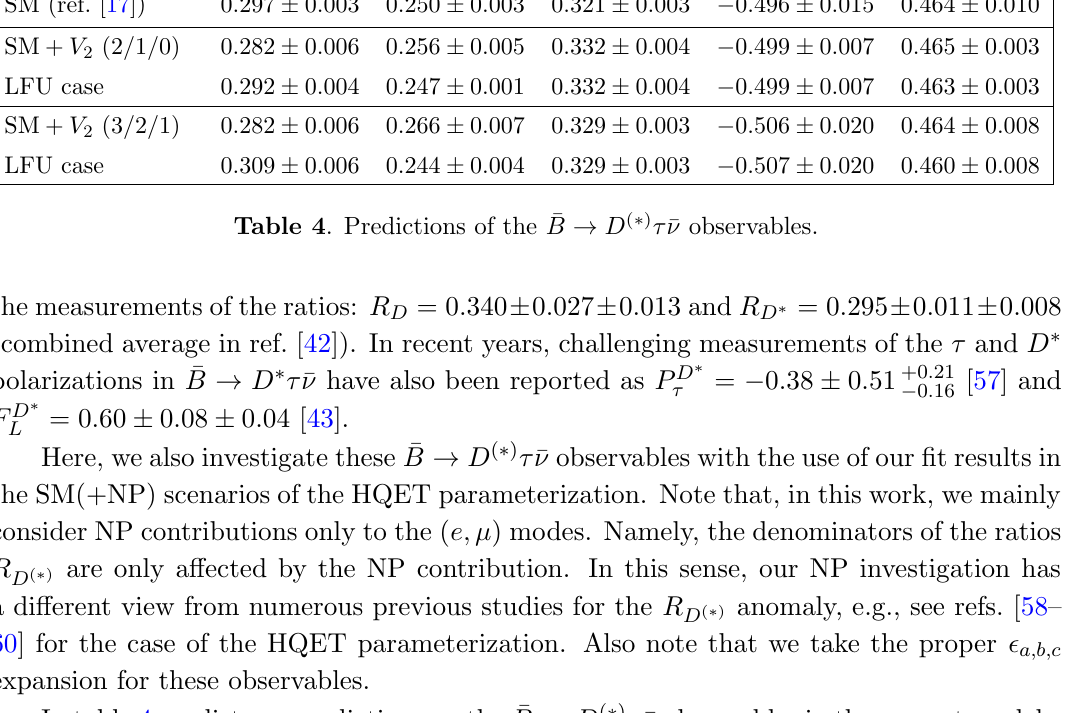
Table 4 . Predictions of the (cid:22) B